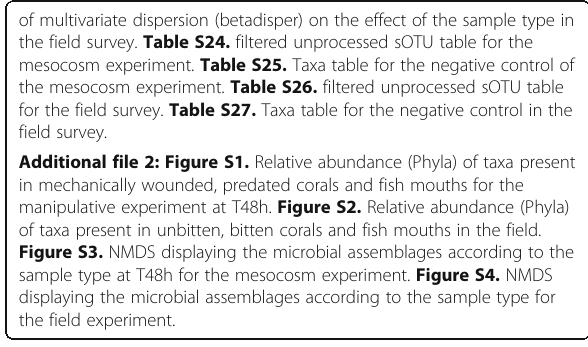
Additional file 1: Table S1. Results of the permutational ANOVA on the bacterial assemblages according to the sample type (control, predated coral and fish mouth) assessed at Ti and Tf for the mesocosm experiment. Table S2. Results of pair-wise tests on the effect of the sam- ple type on the bacterial assemblages for the mesocosm experiment at Ti and Tf. Table S3. Average relative abundance of the families present in the fish mouths for the mesocosm experiment. Table S4. Average relative abundance of the families present in mechanically wounded corals at Ti for the mesocosm experiment. Table S5. Average relative abundance of the families present in mechanically wounded corals at Tf. Table S6. Average relative abundance of the families present in the pre- dated corals at Ti for the mesocosm experiment. Table S7. Average rela- tive abundance of families present in predated corals at Tf. Table S8. Results of the permutational ANOVA on the bacterial assemblages ac- cording to the sample type assessed for field experiment including or not water samples. Table S9. Results of pair-wise tests on the effect of the sample type on the bacterial assemblages for the field experiment. Table S10. Average relative abundance of the families present in the fish mouths for the field experiment. Table S11. Average relative abundance of the families present in naturally unbitten corals in the field. Table S12. Average relative abundance of families present in bitten corals for the field experiment. Table S13. Results of ANOVA and non-parametric tests of the effect of the sample type on alpha diversity metrics (Ob- served Richness and Shannon-Wiener Index) for the mesocosm experi- ment at Ti and Tf. Table S14. Results of posthoc tests assessing the effect of the sample type on alpha diversity metrics (Observed Richness and Shannon-Wiener index) for the mesocosm experiment at Ti and Tf. Table S15. Results of ANOVA and non-parametric tests on the effect of the type of sample on alpha diversity metrics (Observed Richness and Shannon-Wiener index) for the field experiment. Table S16. Results of posthoc tests on the effect of the sample type on alpha diversity metrics (Observed Richness and Shannon-Wiener index) for the field experiment. Table S17. Results from differential abundance analyses (DESeq2) on the effect of the sample type at Ti for the mesocosm experiment. Table S18. Average relative abundance of taxa present in greater differential abun- dance in predated corals compared to mechanically wounded corals for the mesocosm experiment at Ti and Tf. Table S19. Results from differen- tial abundance analyses (DESeq2) on the effect of the sample type at Tf for the mesocosm experiment. Table S20. Differential abundance ana- lysis for the field experiment according to the sampletype. Table S21. Average relative abundance of taxa present in greater differential abun- dance in naturally bitten corals compared to controls for the field experi- ment. Table S22. Results of Permutation test for homogeneity of multivariate dispersions (betadisper) on the effect of the sample type in the field survey. Table S23. Results of Permutation test for homogeneity